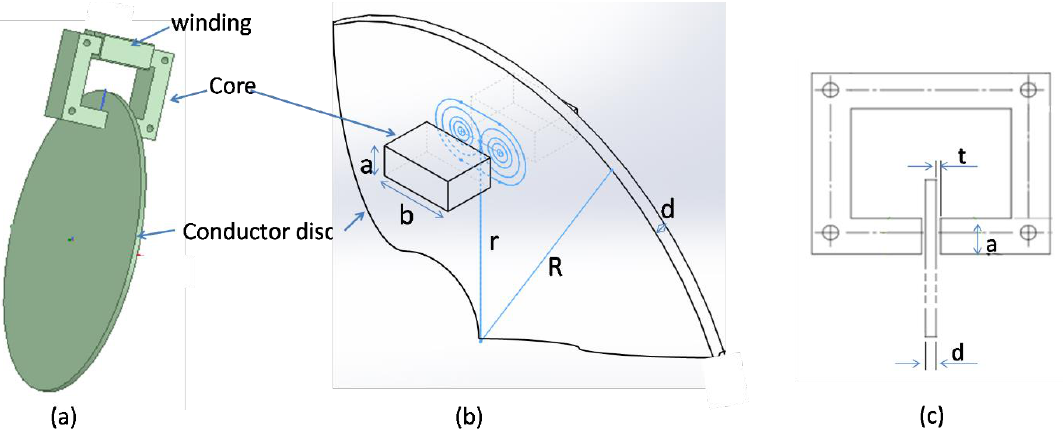
Figure 1. Unipolar axial type eddy current brake (ECB): ( a ) 3D model in general structure, ( b ) eddy current and design variable and ( c ) air gap in cross section area.